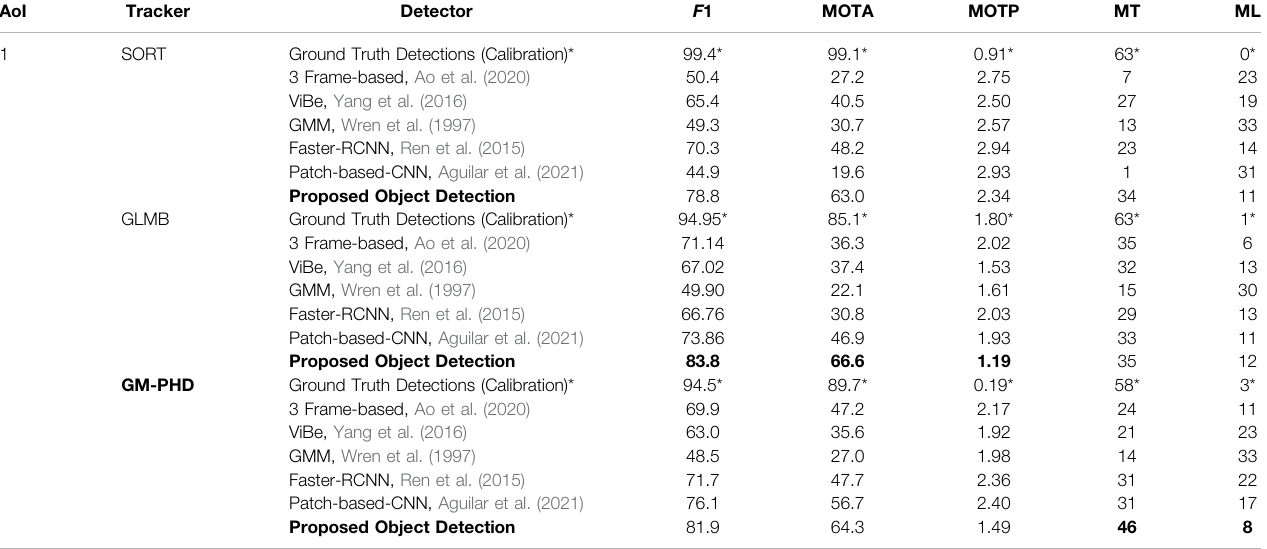
TABLE 4 | Tracking Metrics for AoI 1. *Denotes ground truth measurements used for calibration and fi lter-only testing. AoI Tracker Detector F 1 SORT Ground Truth Detections (Calibration)*